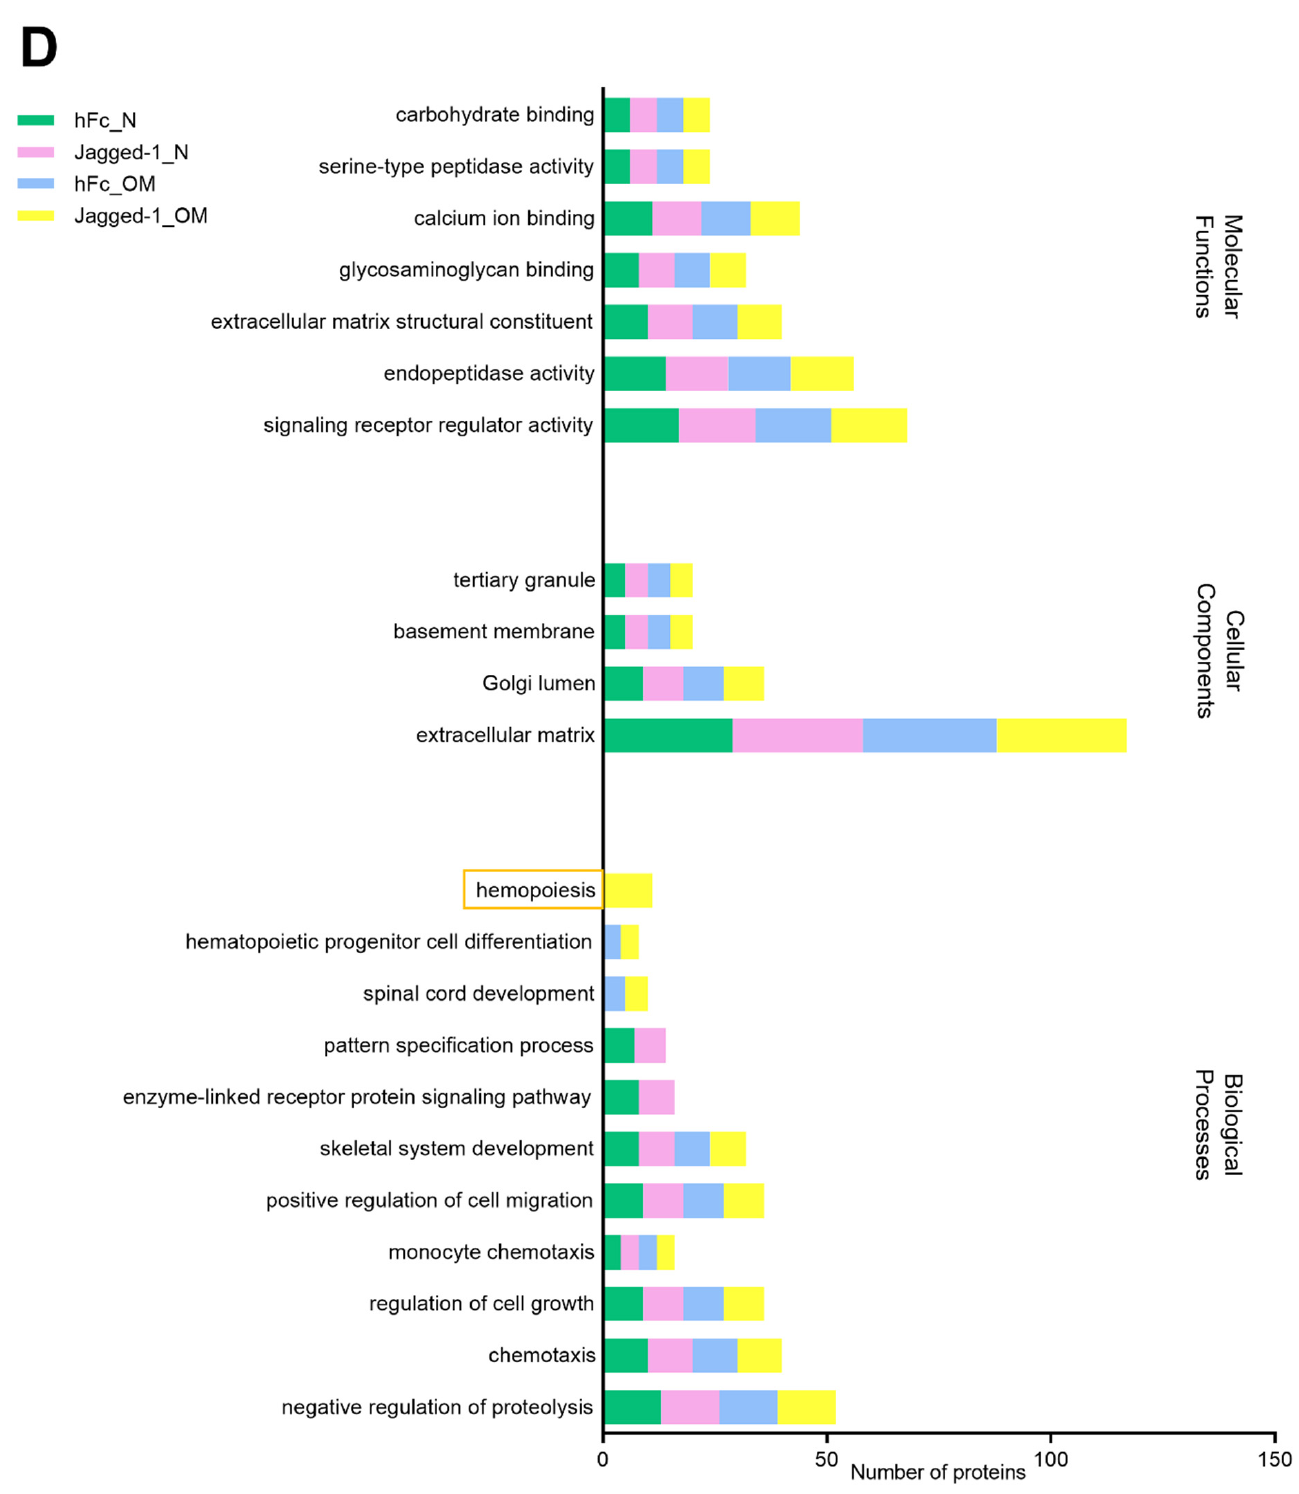
Figure 8. Bar graphs showed the gene ontology in biological processes, cellular components, and molecular functions of ( A ) the cytosol, ( B ) membrane, ( C ) the nucleus, and ( D ) the cytoskeleton compartment, respectively. Unique proteins were specified in a rectangular shape. The analyses were performed using Metascape [32].